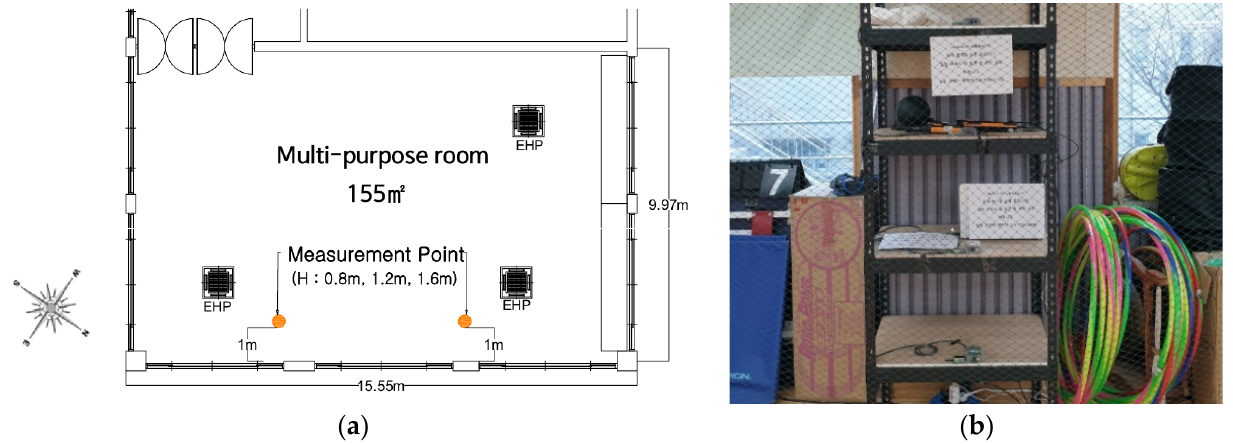
Figure 3. ( a ) Floor plan of the MPA-space of the D elementary school and ( b ) indoor-air-quality measurement experiment.